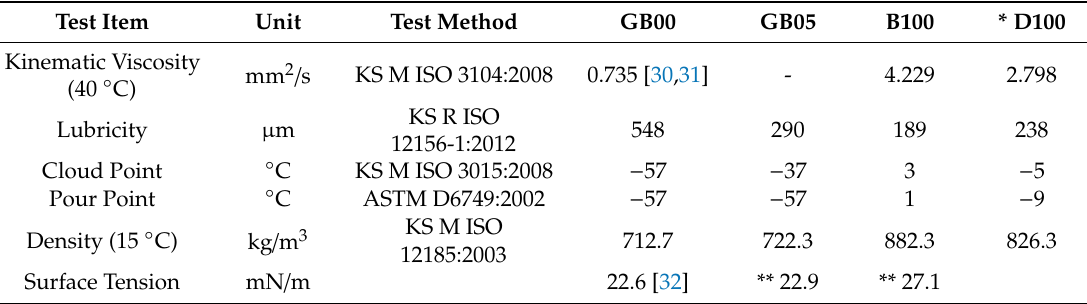
Table 1. Physical properties of the test